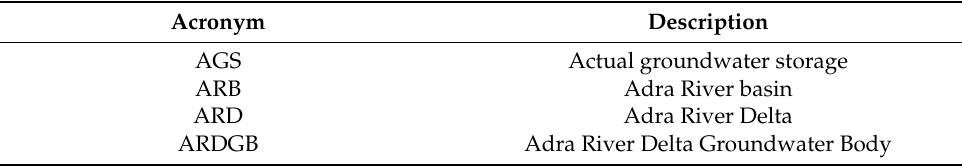
Table 1. Description for acronyms